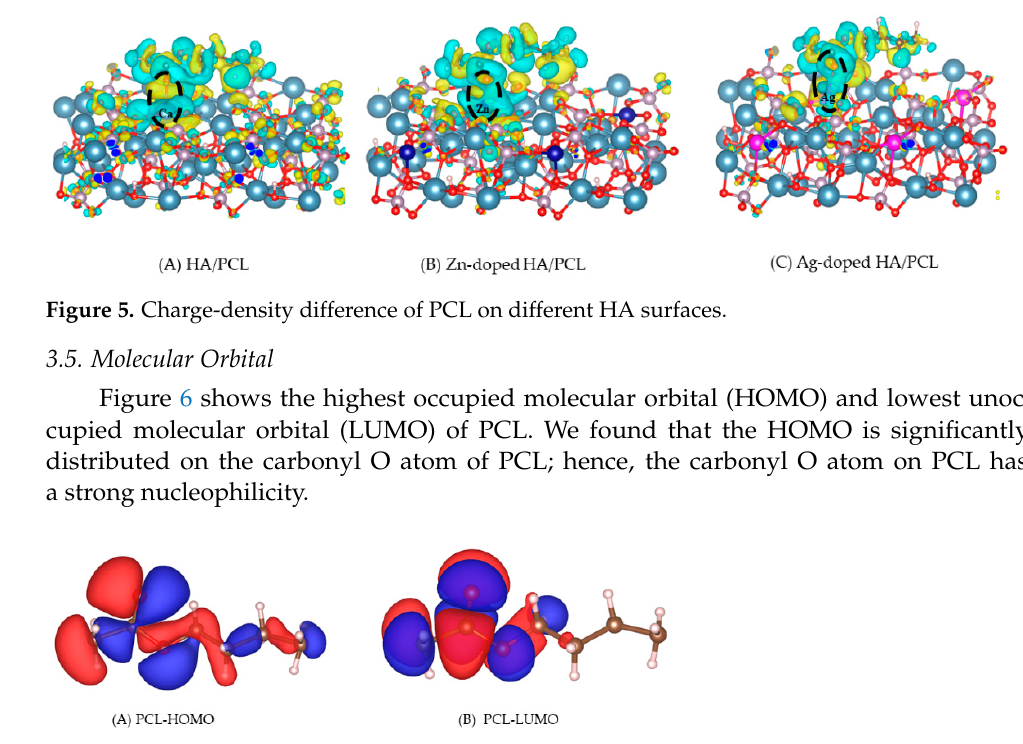
Figure 6. HOMOs and LUMOs of PCL.